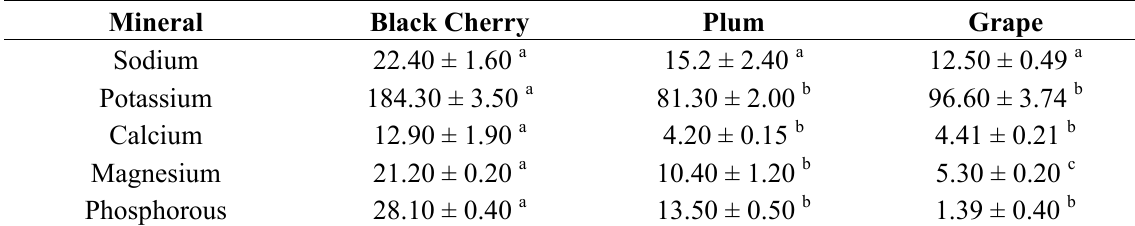
Table 2. Mineral composition of black cherry fruit, plum, and grape * .